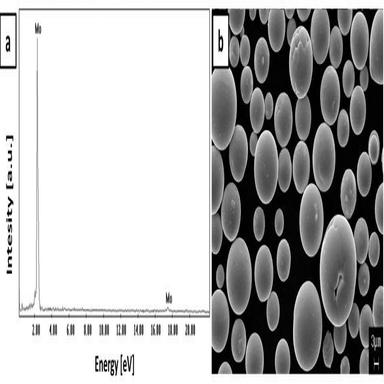
(a) EDS analysis on Mo Powder; (b) secondary electron SEM image of spherical Molybdenum powder (TEKMAT™ Mo-25).